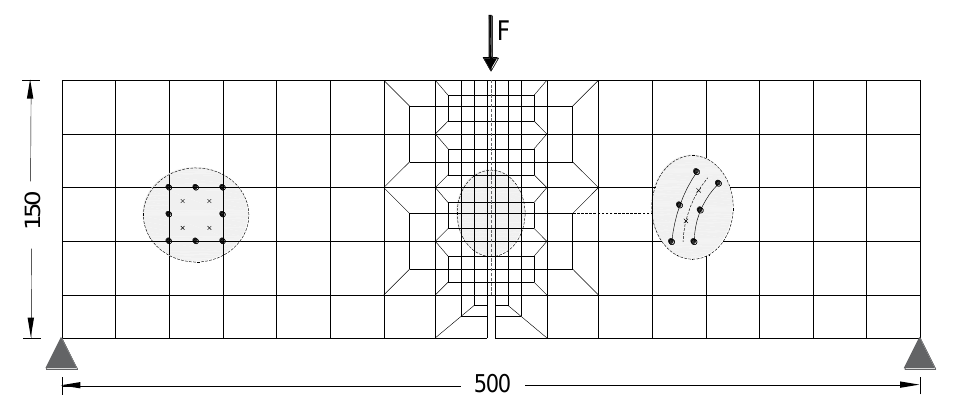
Figure 12. Finite element mesh used in the simulation of the 3PNBBT [36]. Table 7. RSFRC properties used in the numerical simulation of the 3PNBBT.